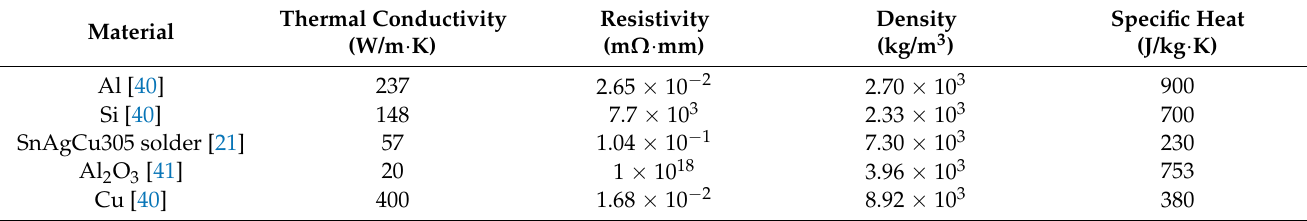
Table 4. Material parameters used in electrical–thermal FE analysis.